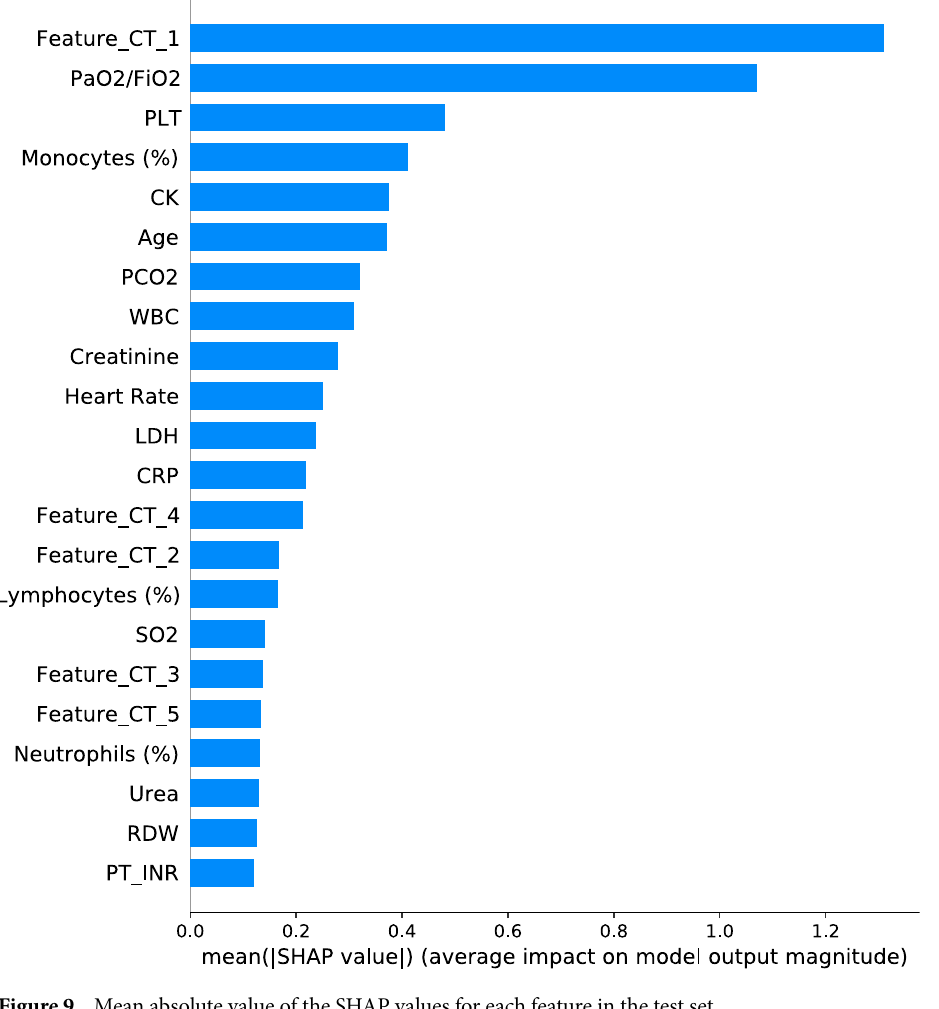
Figure 9. Mean absolute value of the SHAP values for each feature in the test set.